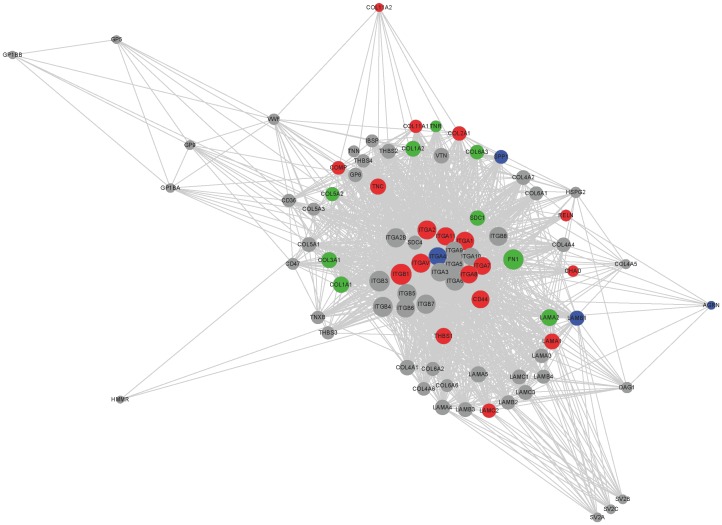
Visualization of molecular network in the KEGG pathway of ECM-receptor interaction using cytoscape.Grey circles represent genes involved in the pathway and the color of the circle represent genes highly expressed in each depot (red:intramuscular, blue: omental, green: subcutaneous).